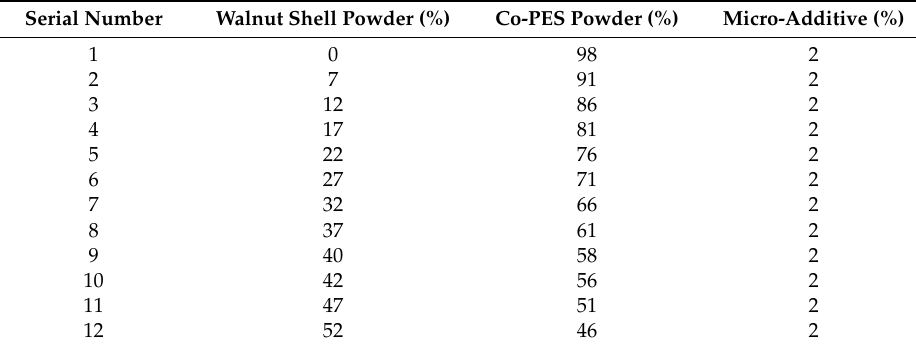
Table 1. Volume content of ingredient in walnut shell composites (WSPC) powder.